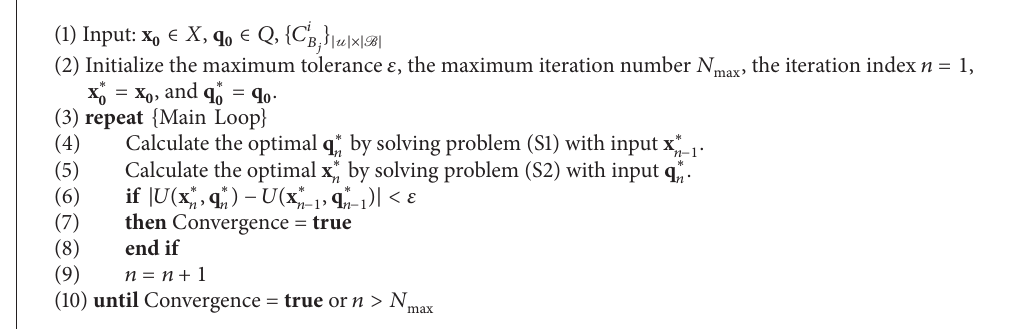
Algorithm 1: The Alternate Convex Search algorithm.